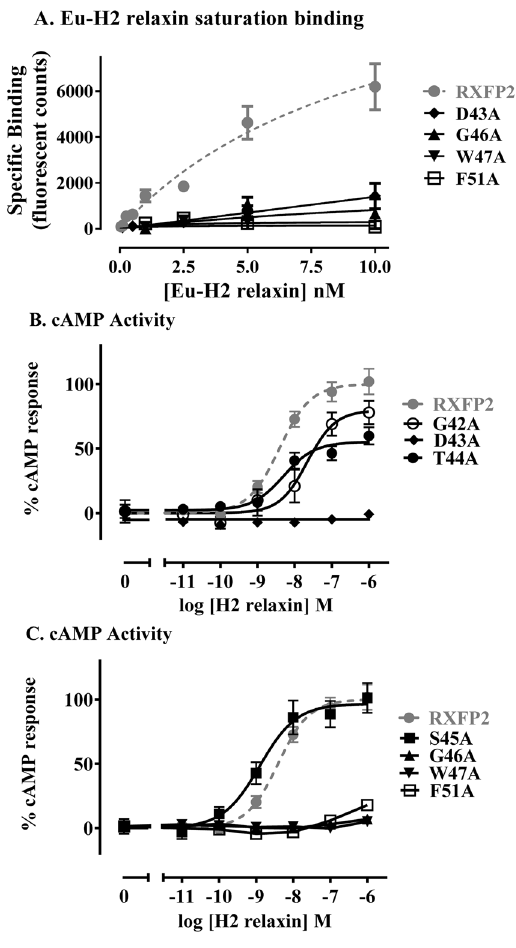
Figure 3. ( A ) Eu-H2 relaxin saturation binding of RXFP2 mutant receptors compared to wild-type RXFP2. ( B , C ) H2 relaxin-induced cAMP response of RXFP2 mutant receptors compared to wild-type RXFP2. Data is presented as mean ± SEM of triplicate determinations from at least three independent